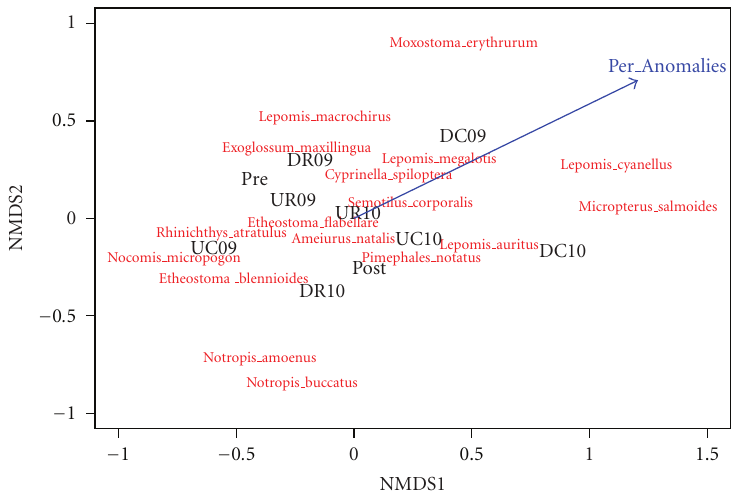
Figure 5: Nonmetric multidimensional scaling (NMDS) ordination plot for fish communities at all sampling reaches (stress = 11.3 for 2- dimensional solution) in the Cacapon River, WVa, USA. Reaches are labeled by reach category: upstream control (impaired reach, but not receiving restoration) denoted “UC”; downstream control denoted “DC”; upstream reference (unimpaired, natural reach) denoted “UR”; downstream reference denoted “DR”. “Pre” denotes the restoration reach prior to restoration (2009), and “Post” denotes the restoration reach after restoration (2010). Selected fish species are positioned in the ordination as weighted averages. Vector lengths indicate relative correlative strength of fish community metrics based on an index of biotic integrity suggested by Daniels et al. [19] ( P ≤ 0 . 05; 1000